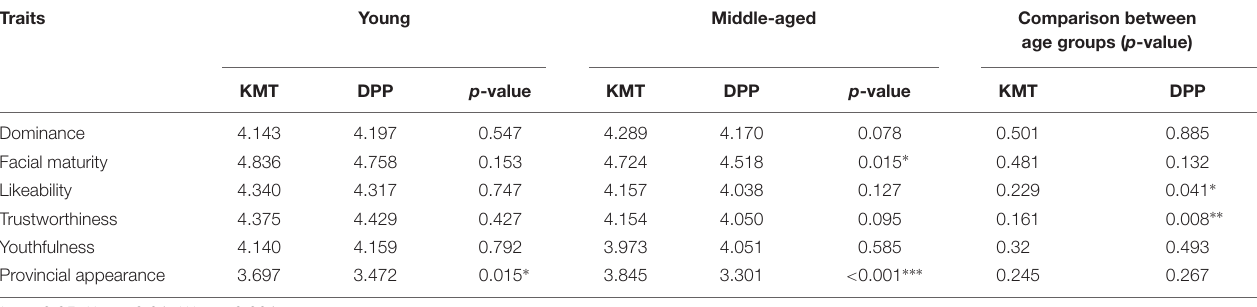
TABLE 1 | The six trait rating scores in young and middle-aged adults in Experiment 2, and the comparisons between the two age groups. Traits Young Middle-aged Comparison between